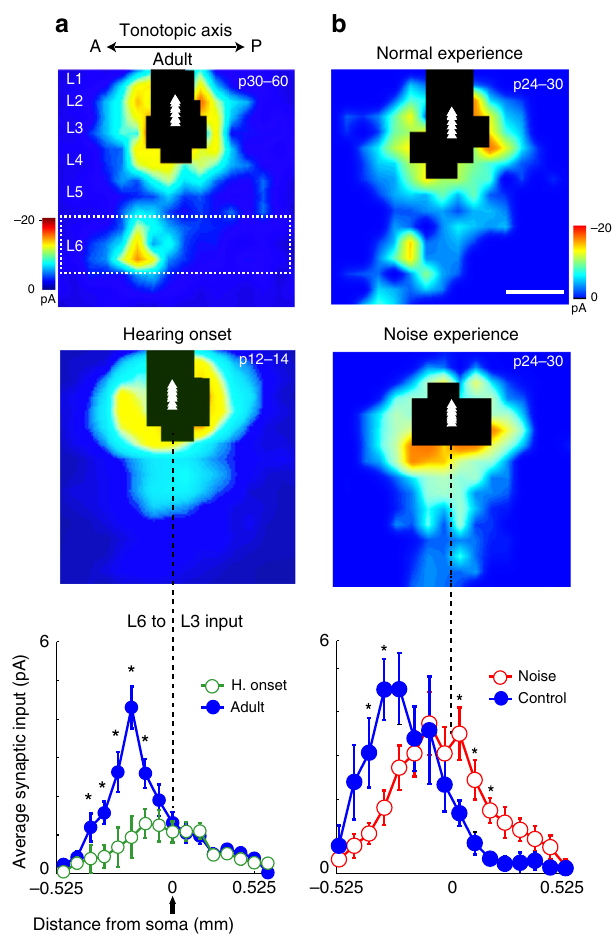
Fig. 9 Development and experience-dependence of the L6 → L3 out-of- column circuit motif. a Comparison of synaptic input to L3 in the ACx of adult (top, P30 – 60; n = 12 cells, 10 mice) and hearing onset mice (middle, P12 – 14; n = 20 cells, eight mice). The lack of out-of-column input from L6 (boxed region) at hearing onset is signi fi cant (bottom, data points marked with stars are signi fi cantly different). b Comparison of synaptic input to L3 in age-matched control mice (top, P24 – 30, n = 25 cells, six mice) and noise-reared mice (middle, P24 – 30, n = 25 cells, six mice). Noise rearing signi fi cantly impacted the formation of out-of-column input from L6 (bottom, data points marked with stars are signi fi cantly different). Scale bar 0.3 mm. All data are presented as mean ±